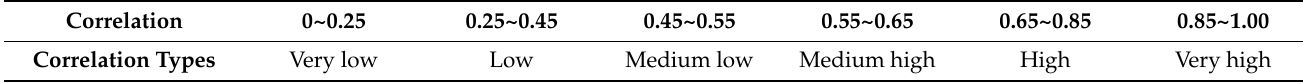
Table 2. Grey correlation index